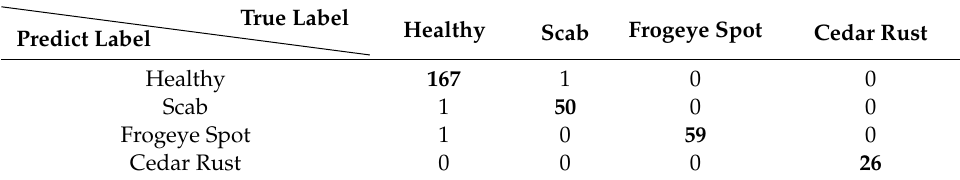
Table 2. Confusion matrix of the prediction results.